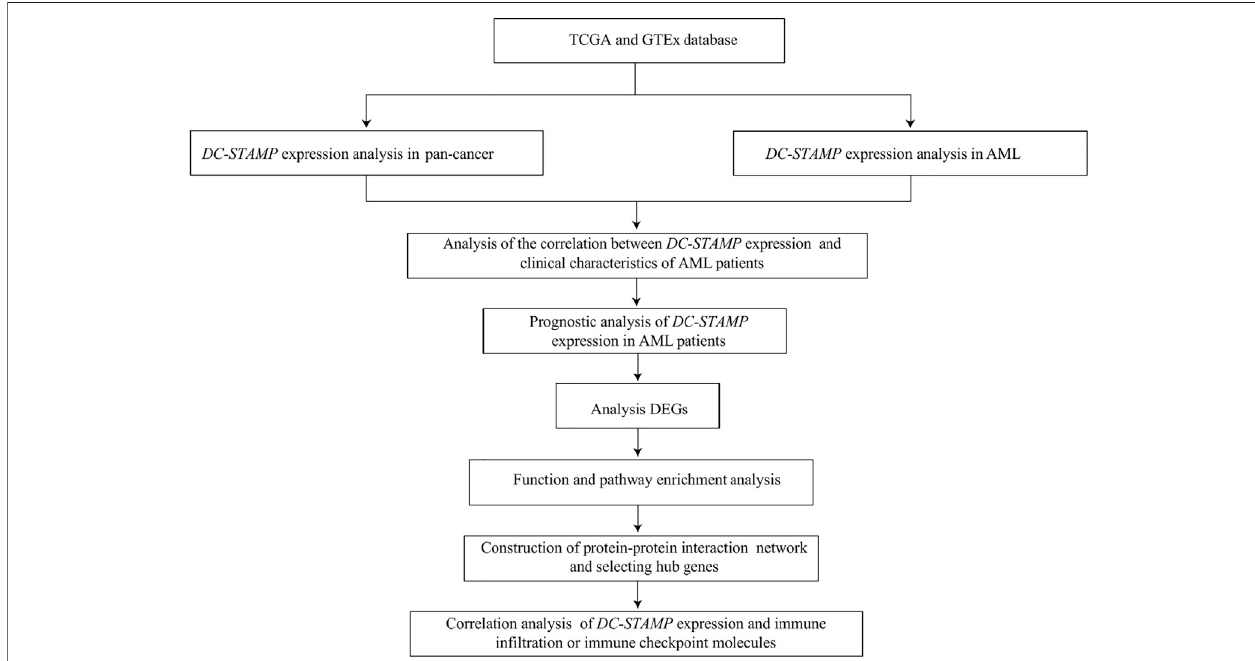
FIGURE 1 | Flowchart of